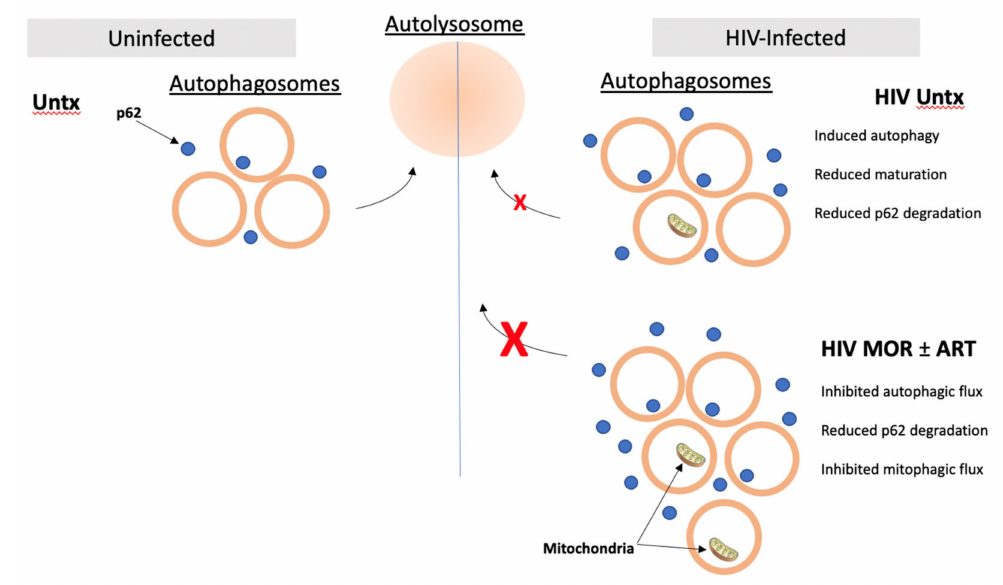
Figure 7. Schematic summarizing the effects of morphine (MOR) and ART for 24 h on in bulk autophagy, p62-mediated autophagy, and mitophagy in the context of HIV from autophagy induction to autophagosome (APG) maturation into autolysosomes (curved arrows). HIV infection of primary human macrophages (HIV Untx) increases the number of APG present by inducing autophagy and inhibiting maturation. HIV increases p62 levels by inhibiting selective autophagy. MOR+ART treat- ment of HIV-infected macrophages further induces autophagy and inhibits maturation, increasing the number of APG in infected cells. MOR+ART treatment also inhibits p62 flux and mitophagy in HIV-infected MDM, increasing p62 levels and the number of APG containing undigested mito- chondria. Inhibited autophagy in macrophages, which are CNS reservoirs for HIV, may increase neuropathogenesis in people with HIV taking opioids and